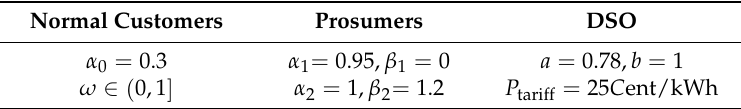
Table 1 . Parameters of various stakeholders in DN. DN: distribution network , DSO: distribution Table 1. Parameters of various stakeholders in DN. DN: distribution network, DSO: distribution system operator. system operator.